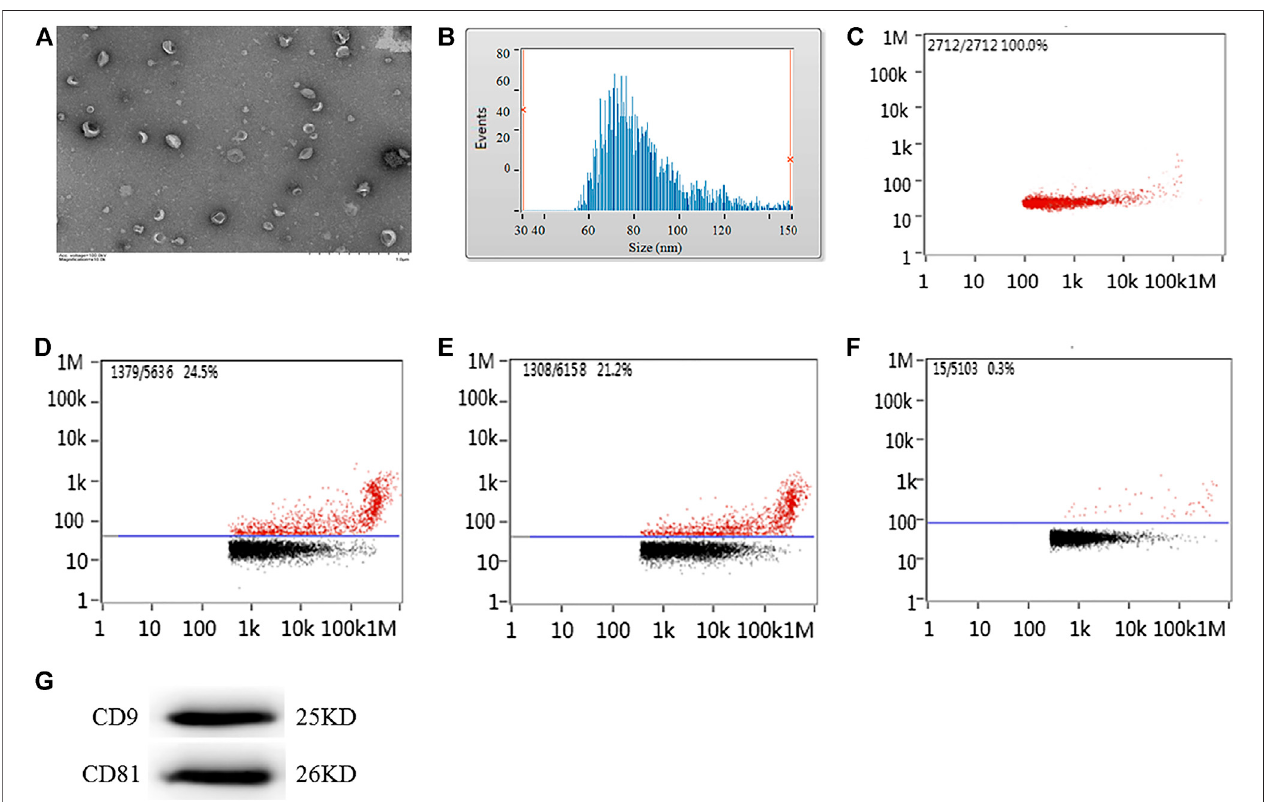
FIGURE 1 | Morphology, diameter, concentration, and protein labeled positive rate detection for exosomes extracted from the supernatant of microglial cells cultured for 24 h. (A) Transmission electron microscopy analysis for morphology of exosome. Scale bars (cid:2) 500 nm. Nanoparticle tracking analysis for (B) diameter of exosome or (C) concentration of exosome. Flow cytometry analysis for (D) CD9-labeled positive rate, (E) CD81-labeled positive rate, or (F) control FITC-IgG labeled positive rate. (G) The protein expression of CD9 and CD81 exosome marker proteins were examined by western blot. Western blots were quanti fi ed. Nine independent experiments were